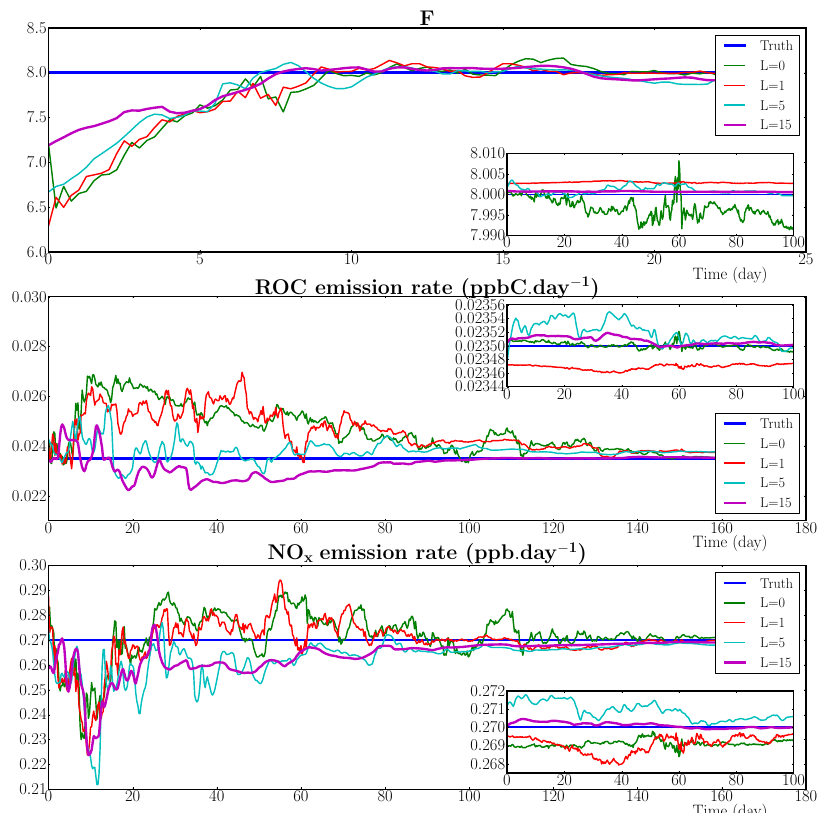
Figure 10. Time evolution (days) of the parameter variables for several DAW lengths without spin-up (main) or after a long time (inset). The case L = 0 corresponds to the ensemble transform EnKF. F is shown with the original Lorenz unit, while the emission rate unit is ppbCday − 1 or ppbday − 1